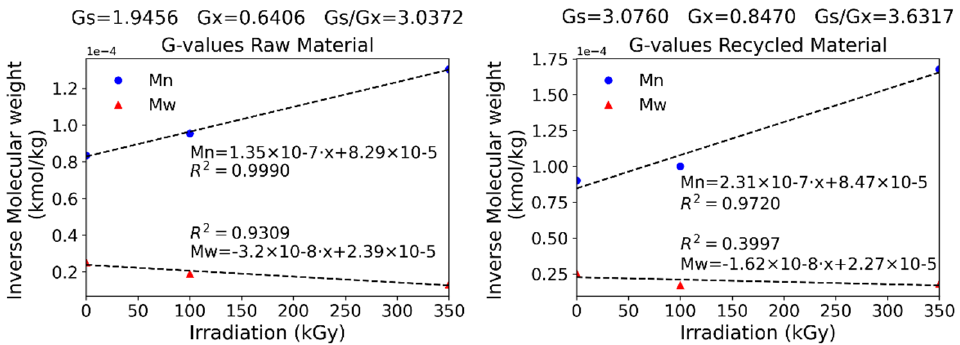
Figure 12. Radiolytic yields for virgin and recycled materials. G-values in (100 eV) − 1